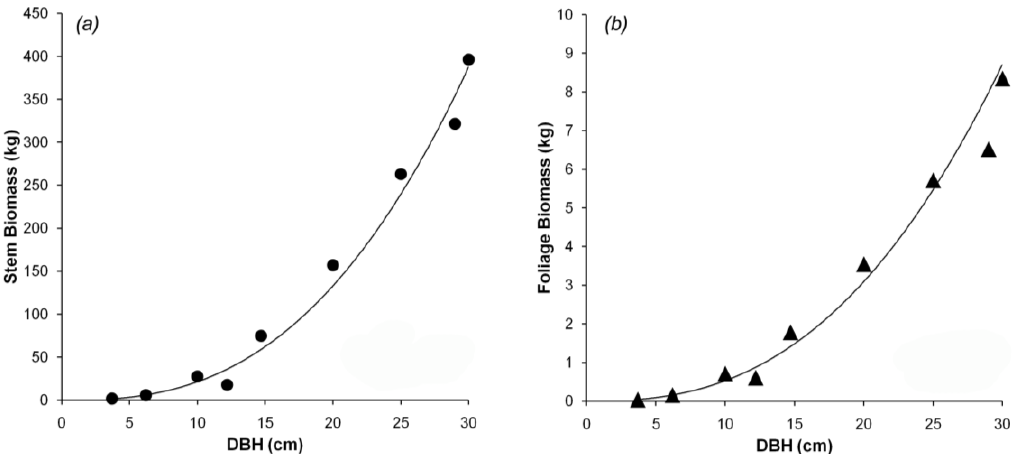
Figure 2. Allometric relationship between (a) stem biomass and DBH (open circle); and (b) foliage biomass and DBH (solid rectangular) at Takayama. The allometric equation of stem biomass and DBH is y = 0.049x 2.64 , while foliage biomass and DBH is y = 0.002x 2.56 . The values from the allometric equation were used to calculate the parameter values in the biomass partitioning.